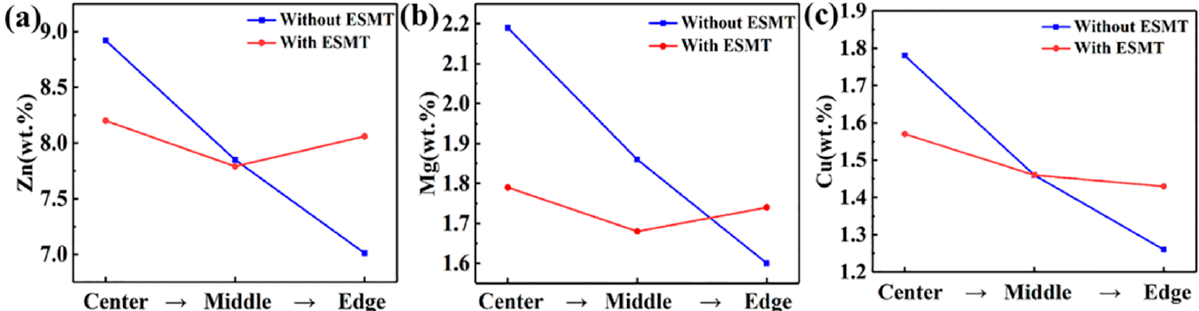
Figure 6. Concentration distribution of Zn, Mg, and Cu elements in different positions of the squeeze castings under different treatment conditions: ( a ) Zn; ( b ) Mg; ( c ) Cu.